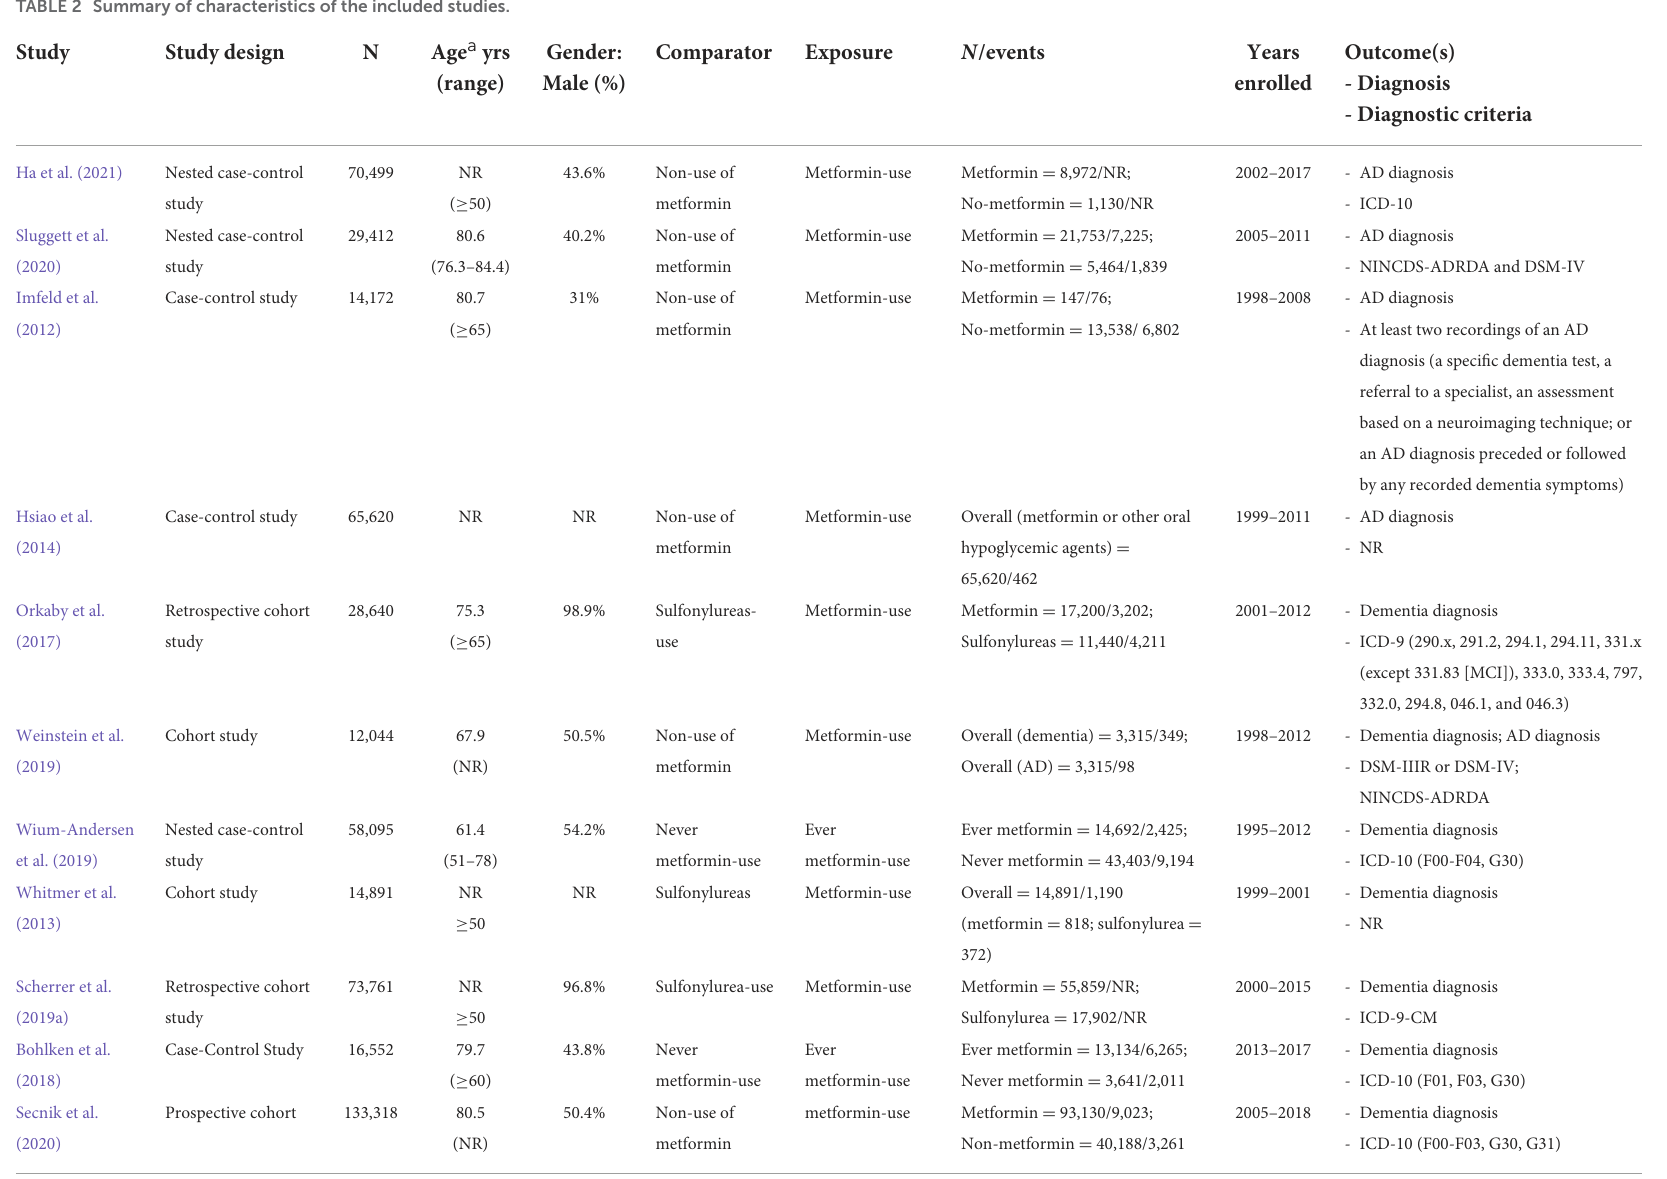
TABLE 2 Summary of characteristics of the included